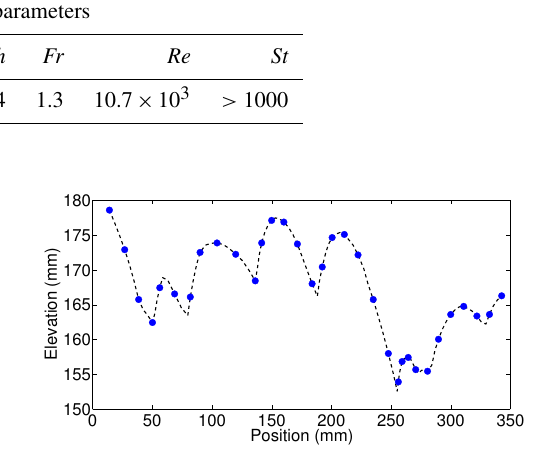
Figure 2. An example saltator trajectory obtained during the ex- perimental run with a sediment feed rate of 40 MPM; hydraulic conditions listed in Table 1. Trajectories are created for all particles present in the sampling area of the